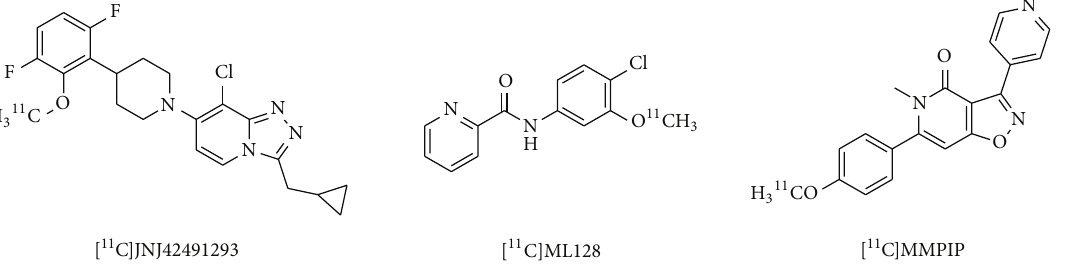
Figure 15: PET Images of the average mGluR5 DVR (0–40min) using [ 11 C]ABP688 in the three diagnostic groups ( 𝑛 = 14 ) [107].